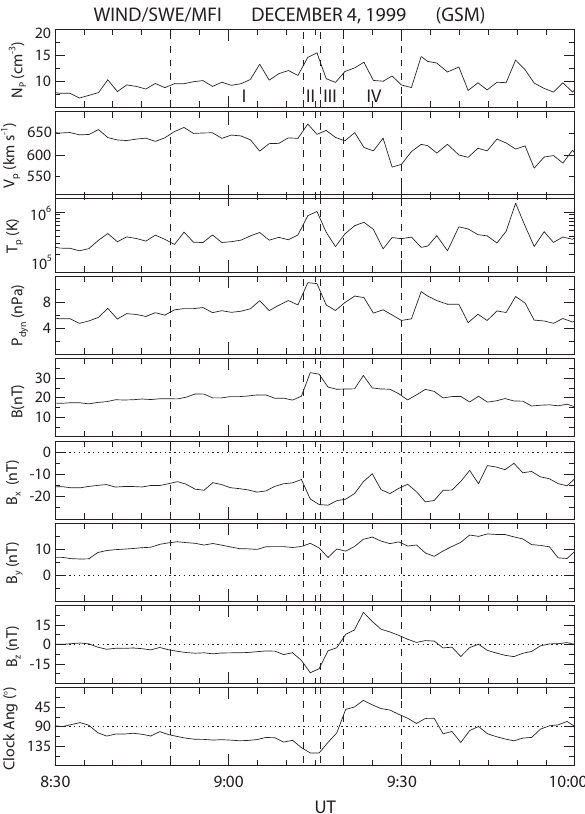
Fig. 11. Wind magnetic field and solar wind plasma data for the interval 08:30–10:00UT. Panels from top to bottom shows proton density, temperature, bulk speed, dynamic pressure, the total mag- netic field and its components B x , B y , and B z . The bottom panel shows the IMF clock angle in the GSM Y-Z plane. Intervals of different magnetic field orientation are delimited by vertical guide- lines.